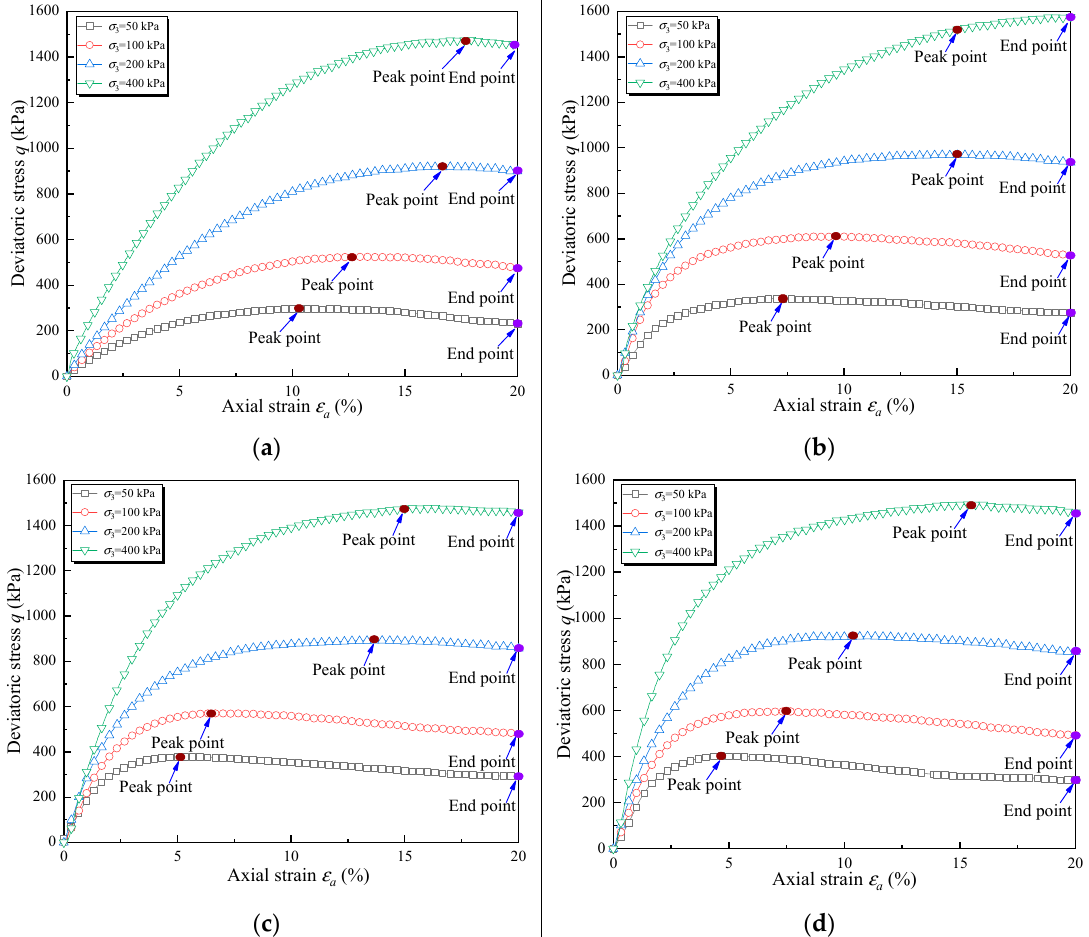
Figure 6. Deviatoric stress-axial strain curves of coral gravelly sand under different confining pressures and water contents: ( a ) ω = 6%, ( b ) ω = 12%, ( c ) ω = 18%, ( d ) ω = 24%.